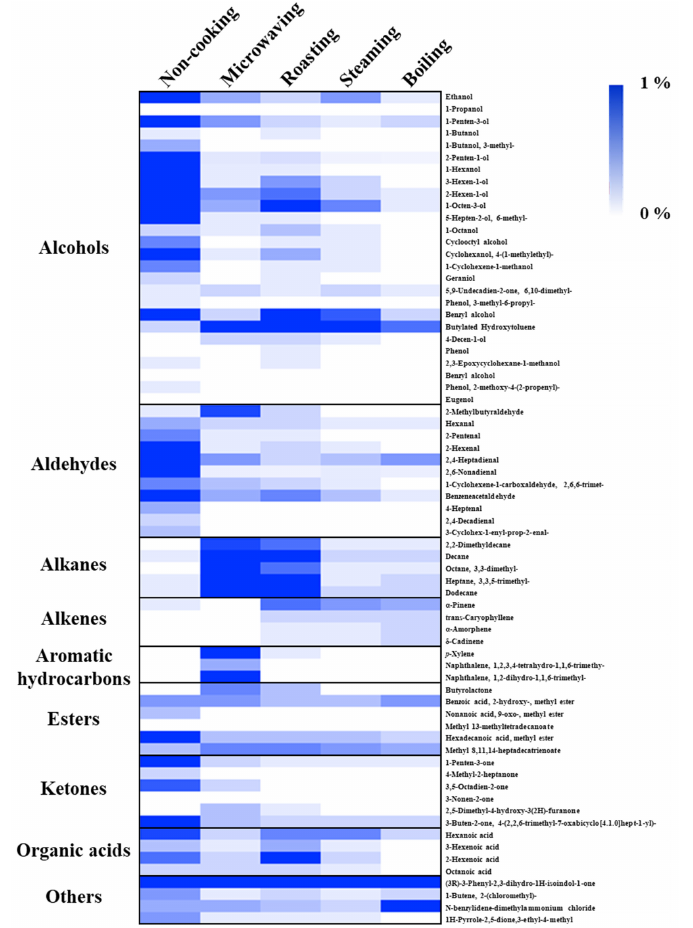
Figure 4. Heat map of VOCs detected in cooked faba leaves by HS-SPME-GC–MS. The data are presented as the percentage for each volatile compound (peak area) of the total peak area of fresh faba leaves.